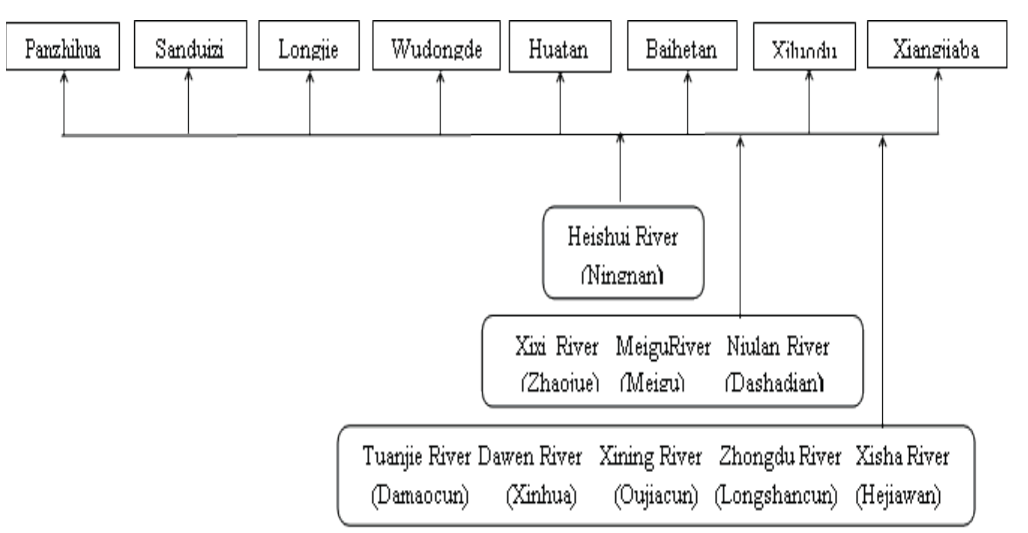
Fig. 2 Location of tributaries to the main